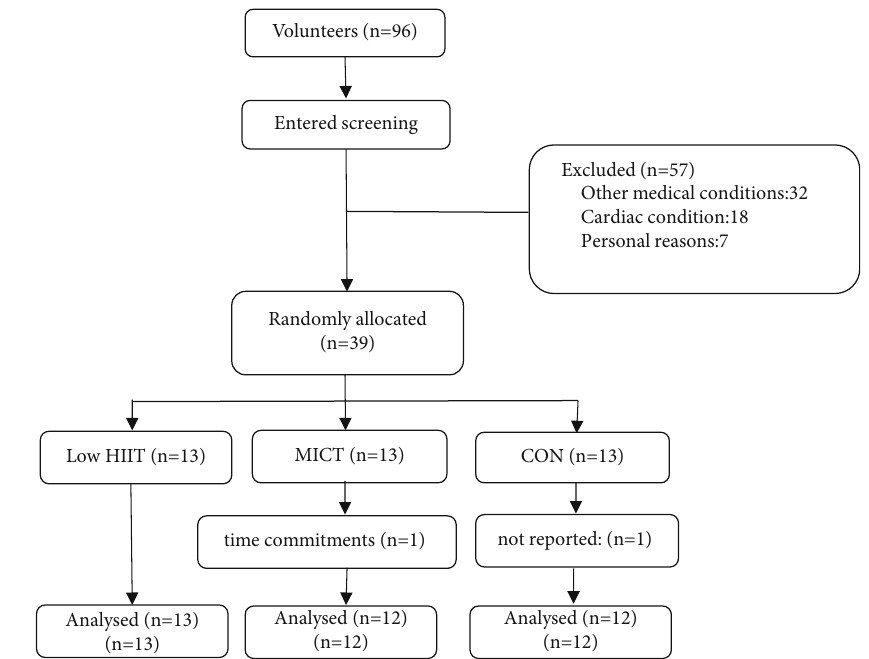
Figure 1: Flow chart of volunteer recruitment for the experiment.